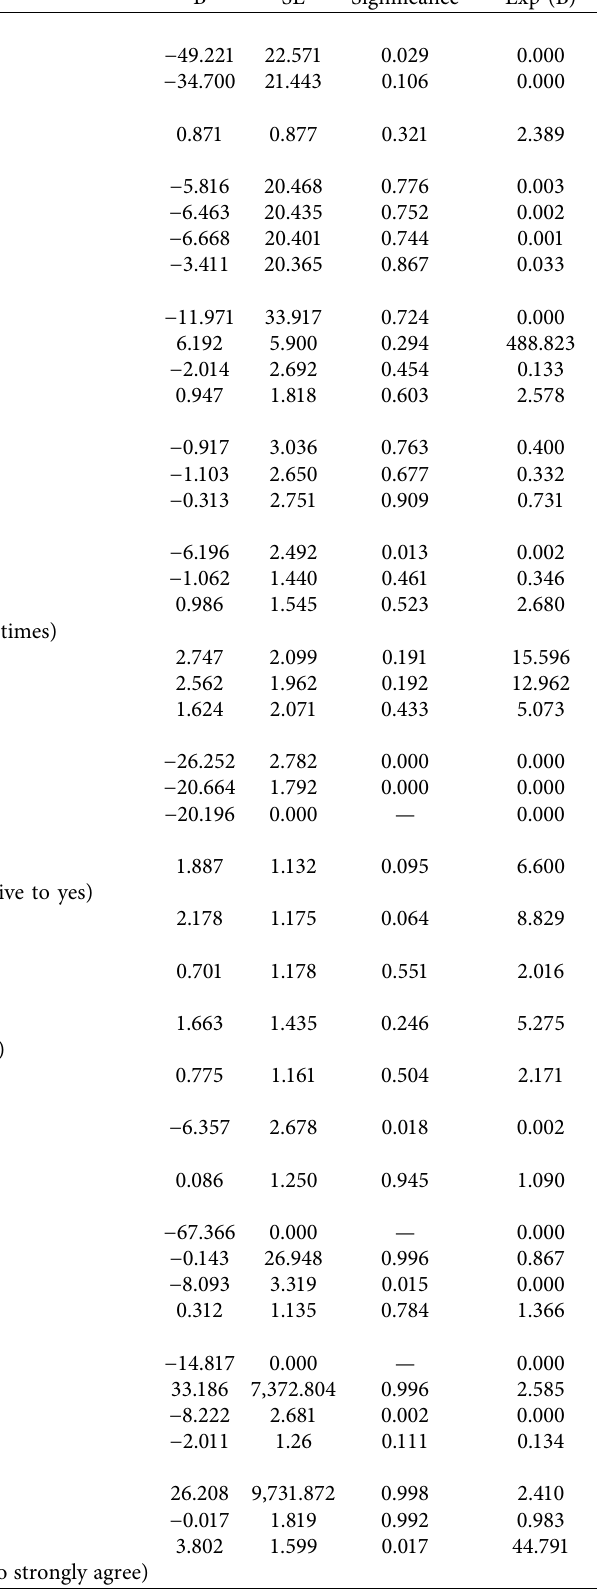
Table 2: Ordinal logistic regression analysis results of Shanghai